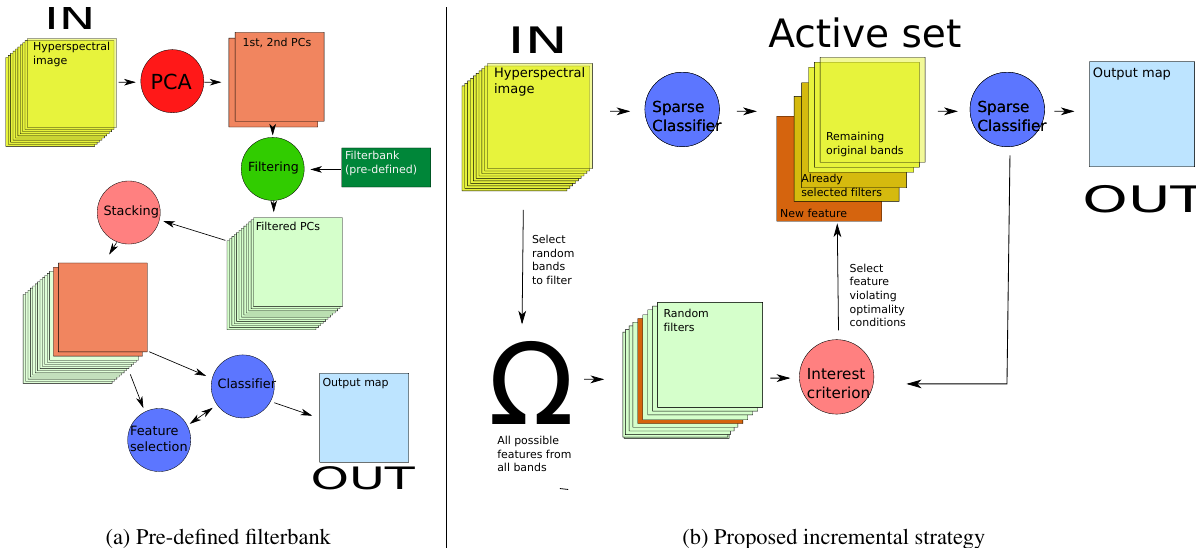
Figure 1: Spatio-spectral classification with contextual filters. (a) Using pre-defined filterbanks, applied on the first principal component ( p = 1) . (b) The proposed incremental system based on active set and sparse